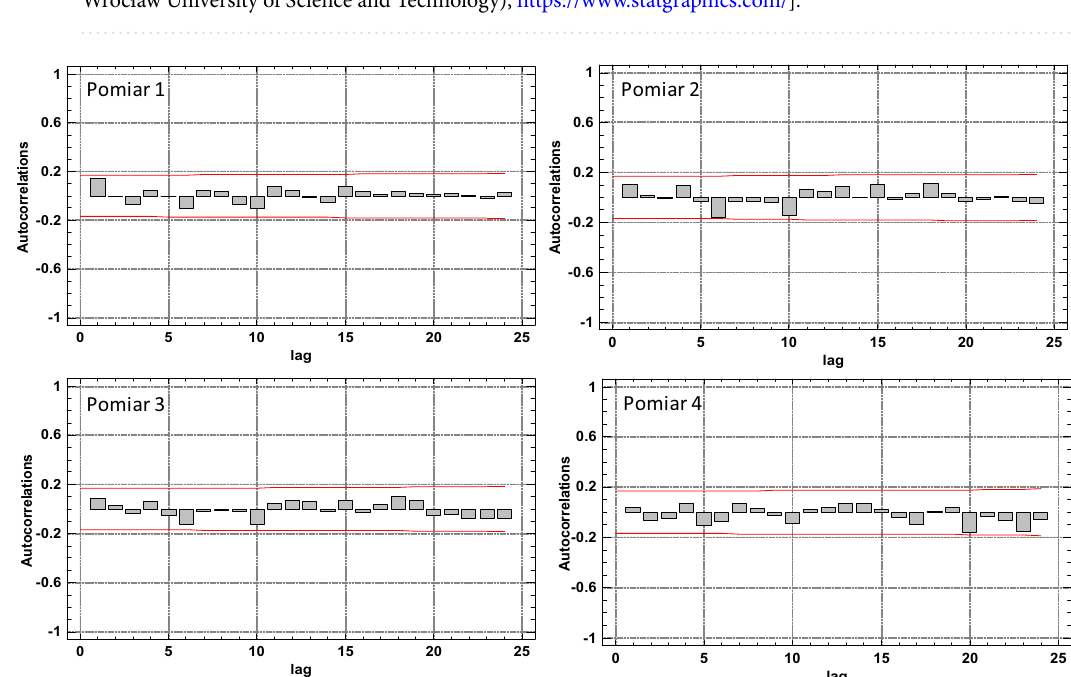
Figure 13. Estimated autocorrelations for various lags for the number of defects (density) in 1-m segments of the 7–8 belt section, for the consecutive scans 5,42 [Statgraphics Centurion Version 18.1.06 64-bit version (academic license of Wrocław University of Science and Technology), https:// www. statg raphi cs.